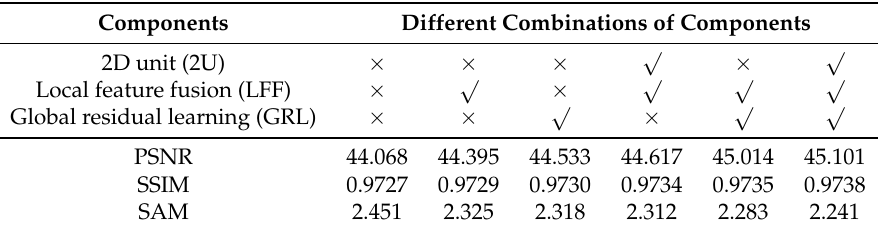
Table 2. Ablation study about the